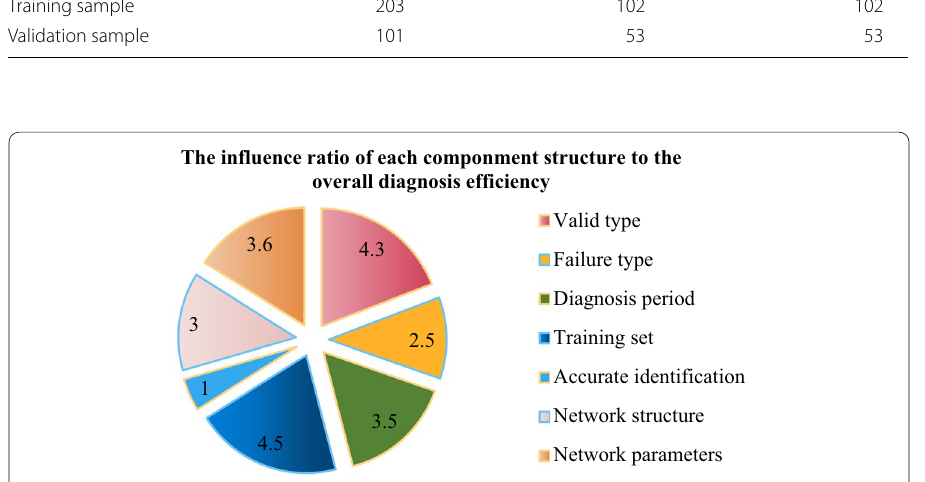
Fig. 13 The influence ratio of each component structure to the overall diagnosis efficiency